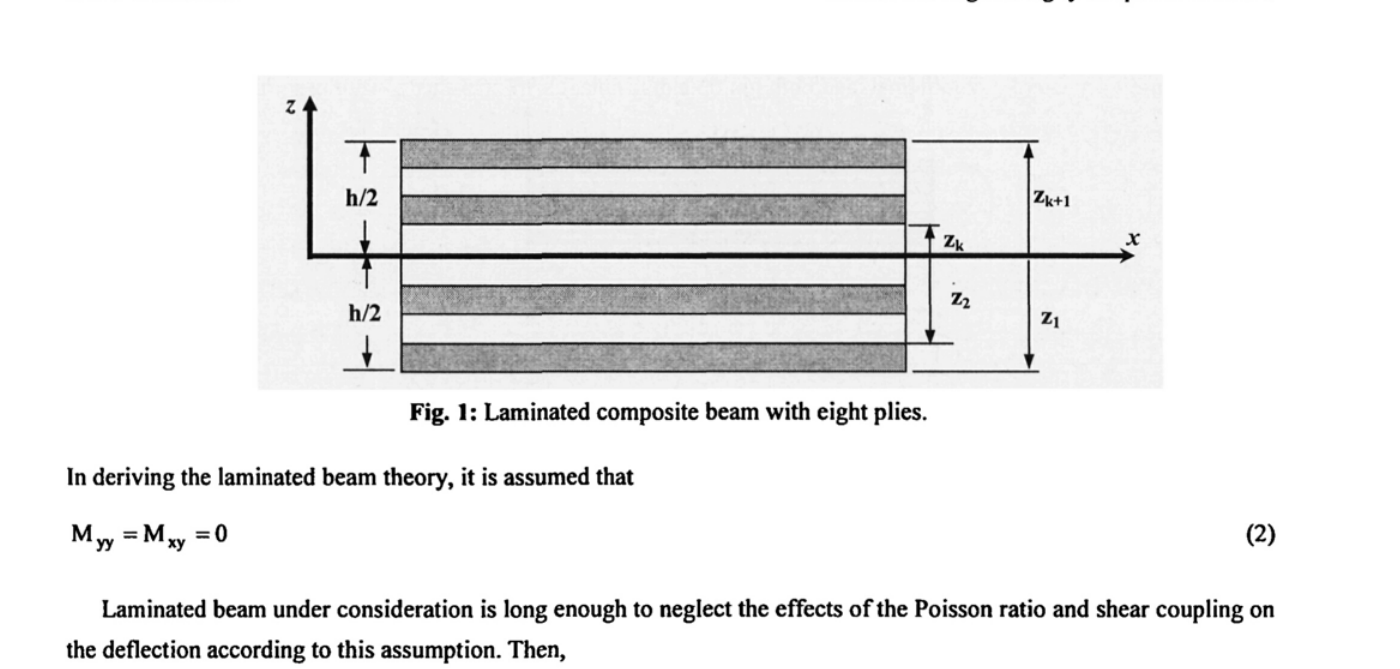
Fig. 1: Laminated composite beam with eight